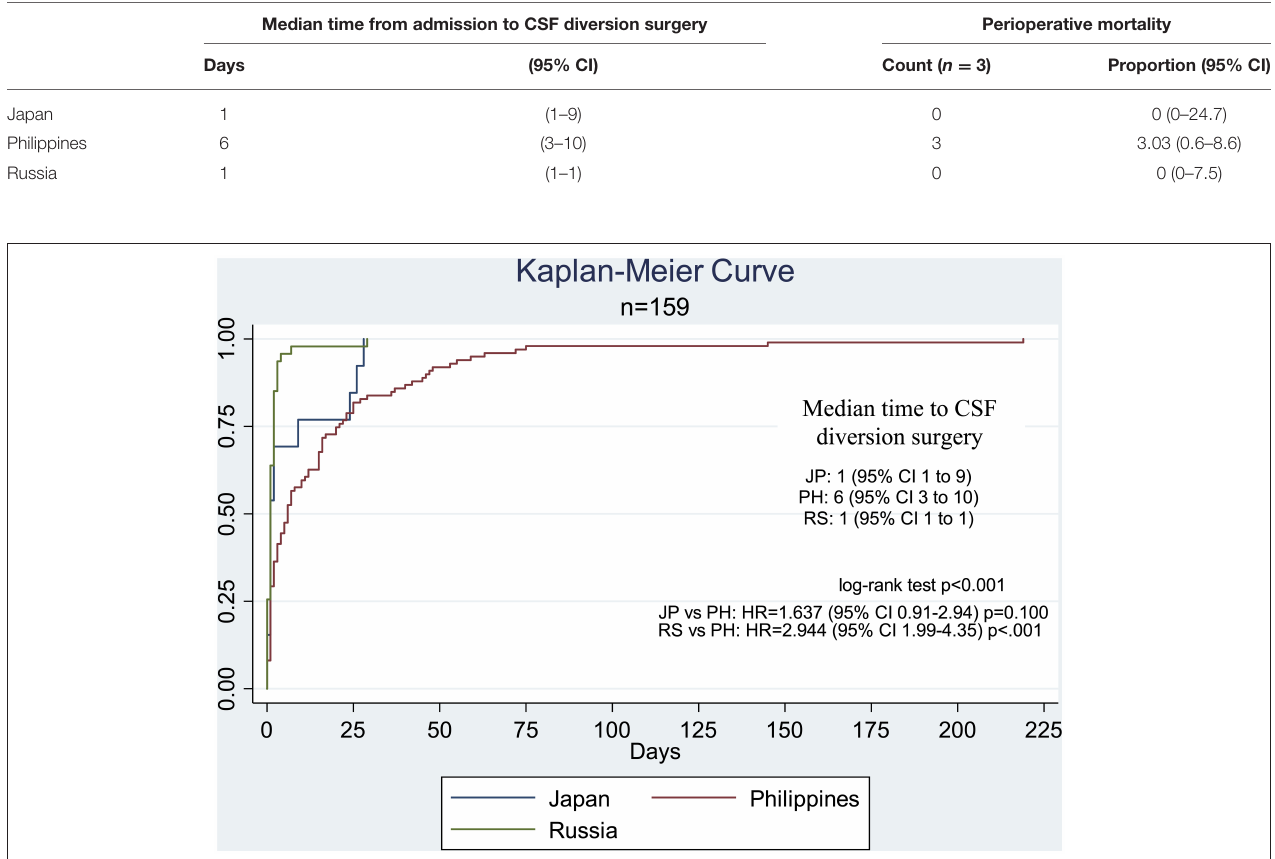
FIGURE 1 | Kaplan–Meier curve comparing the time-to-CSF diversion surgery by country. The median time for the Philippine center was significantly different from that in the Russian center (HR = 2.944, 95% CI 1.99–4.35, p < 0.001) but not the Japanese center (HR = 1.637, 95% CI 0.91–2.94, p =